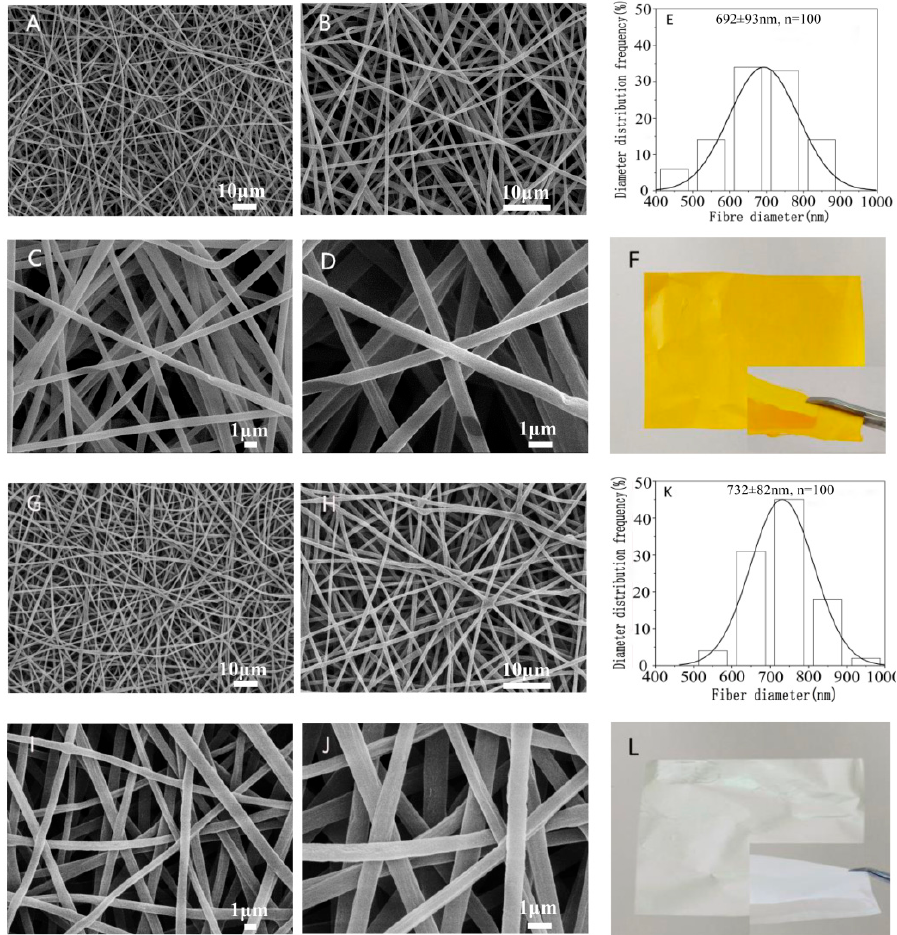
Figure 2. Morphology and diameter distribution of nanofiber membranes with / without emodin.